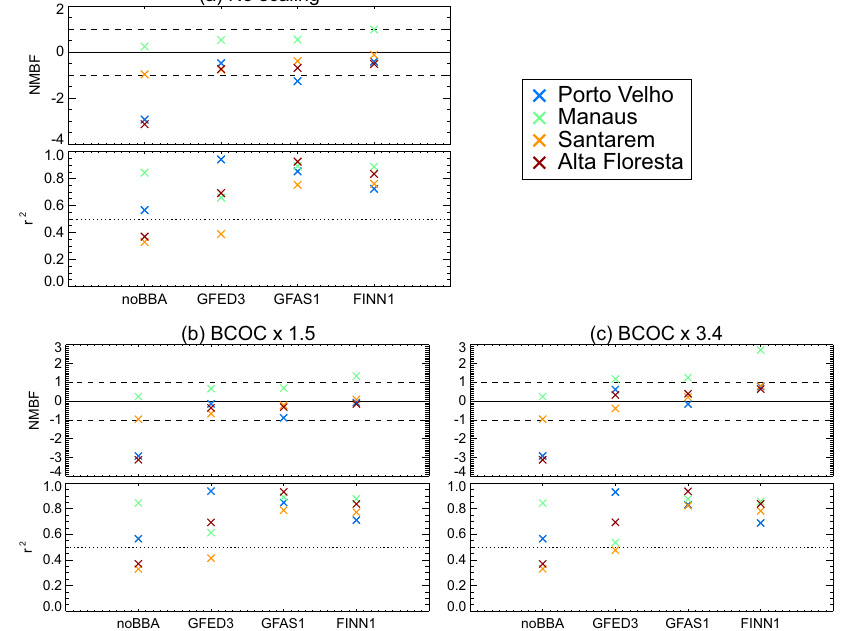
Figure 3. Normalised mean bias factor (NMBF; Yu et al., 2006) and Pearson’s correlation coefficient ( r 2 ) between modelled and observed multi-annual monthly mean PM 2 . 5 concentrations at each of the four ground stations in Amazonia. Results are shown for four model simulations: without fires (noBBA), and with each of the three biomass burning emissions inventories: GFED3, GFAS1, and FINN1. (a) No scaling applied to the fire emissions, (b) particulate (BC / OC) fire emissions scaled up globally by a factor 1.5, and (c) particulate (BC / OC) fire emissions scaled up globally by a factor of 3.4. The dashed lines indicate NMBFs of − 1 and 1, which equate to an underestimation and overestimation, respectively, of a factor of 2. The dotted line indicates an r 2 value of 0.5. Atmos. Chem. Phys., 16, 11083–11106,